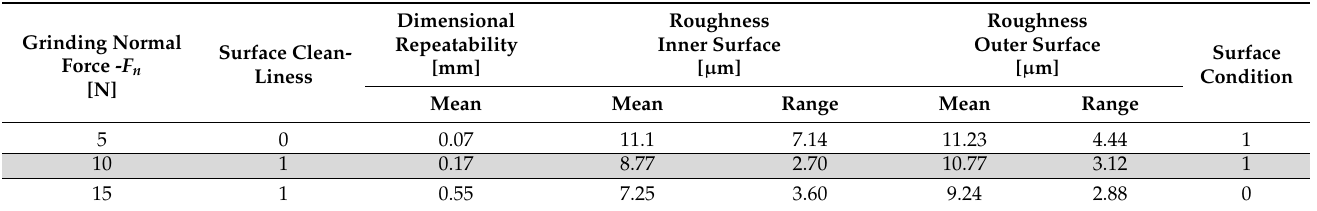
Table 3. Grinding quality depending on grinding normal force setting ( v s = 26 m/s; v f = 4 mm/s). Grinding Normal Force - F